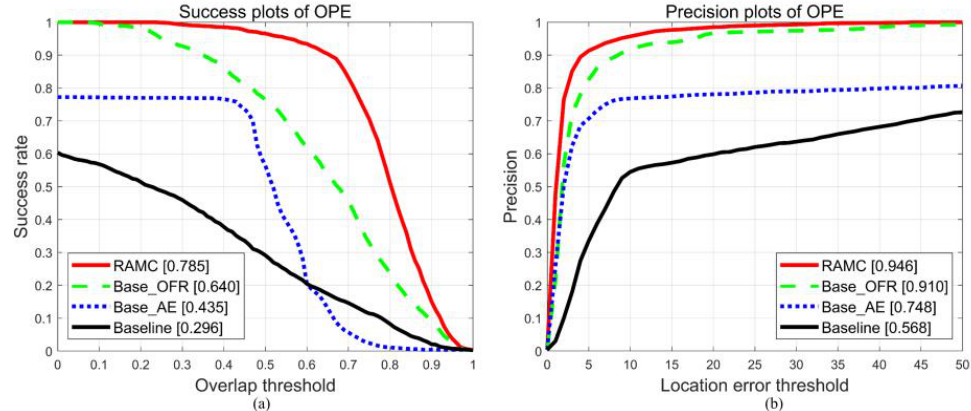
Figure 8. Success plot ( a ) and precision plot ( b ) of the variant trackers on datasets. The values in the